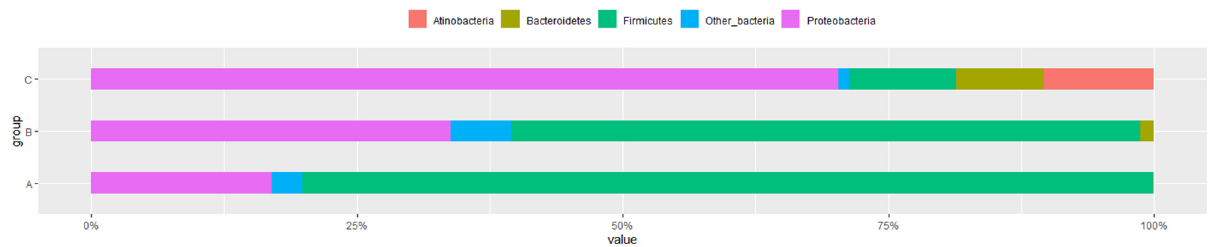
Figure 2. Relative abundance of the major phylum gut microbiota of larval (A), pupal (B), and adult (C) honeybees, Apis cerana, with cut-off of 1%. The abundance of different phyla in the sample is shown by the color gradient of the color block.